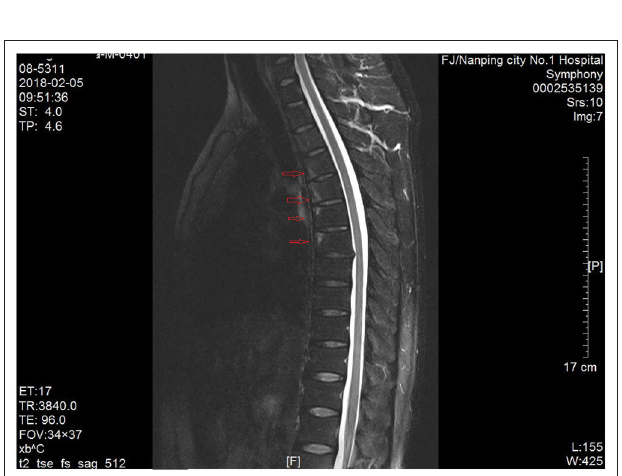
FIGURE 2 | MRI examination of thoracic vertebrae. Abnormal signal of T4–T7 was indicated by a red arrow.